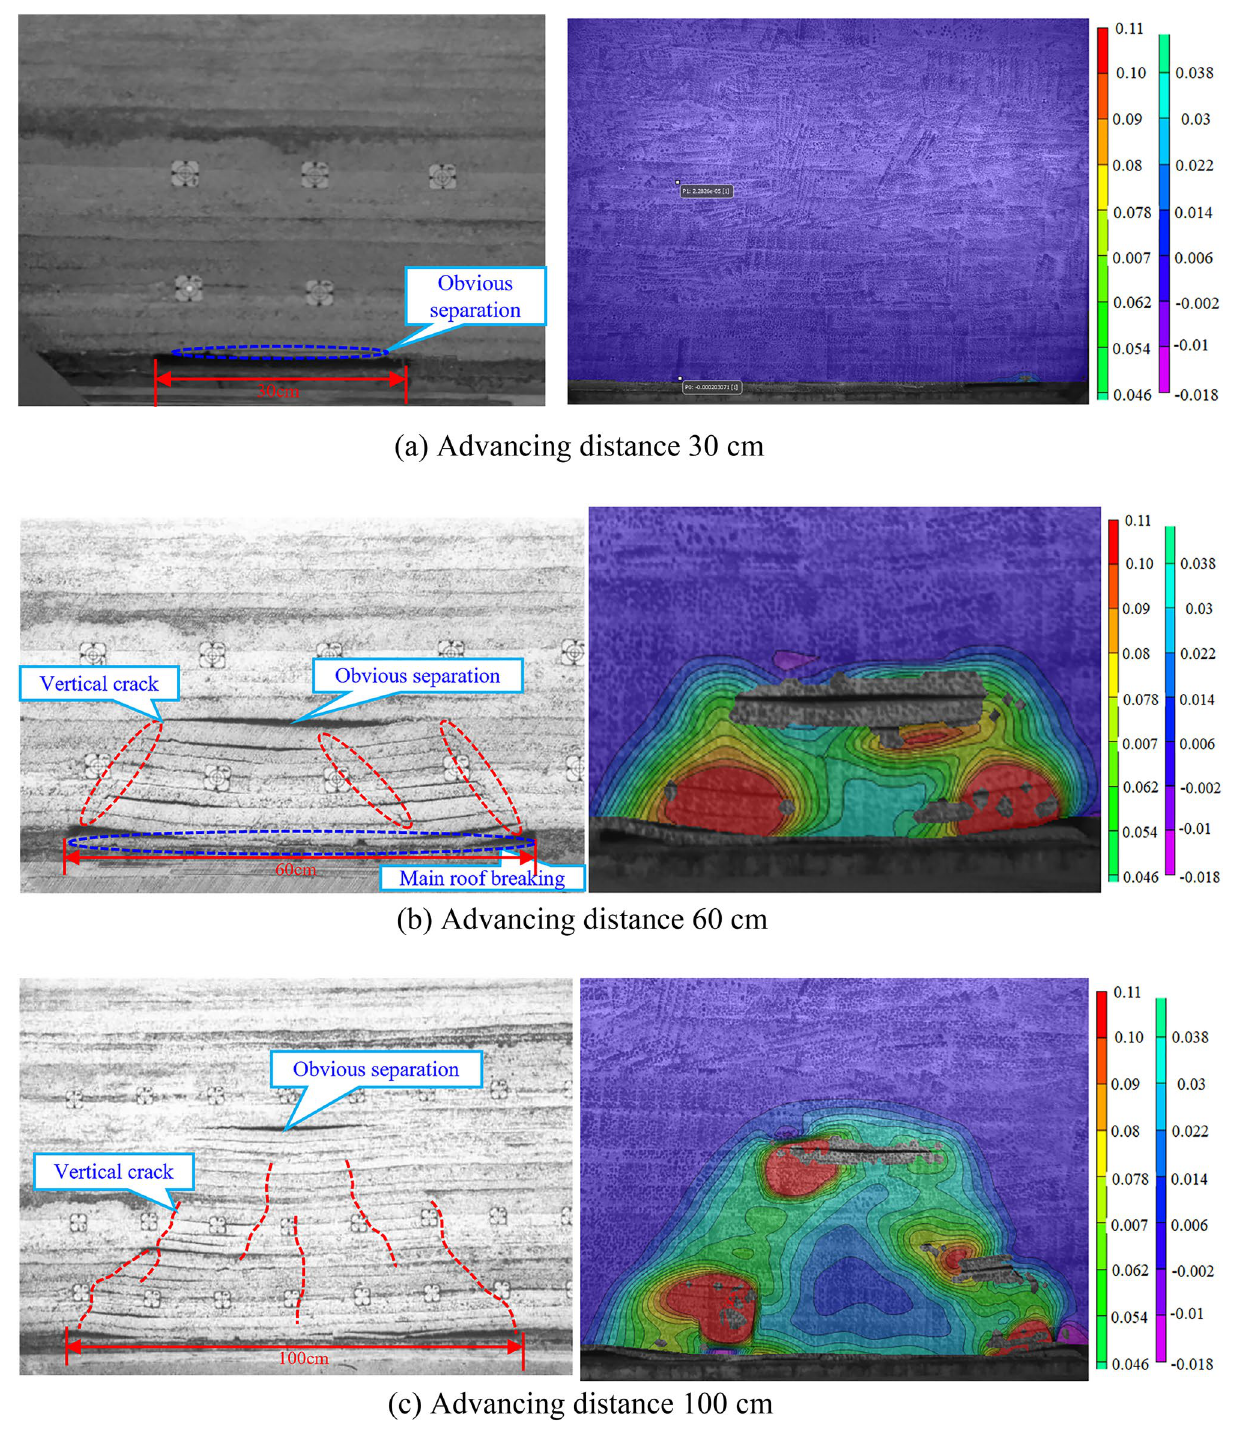
Figure 12. Vertical deformation and fractures evolution of overlying